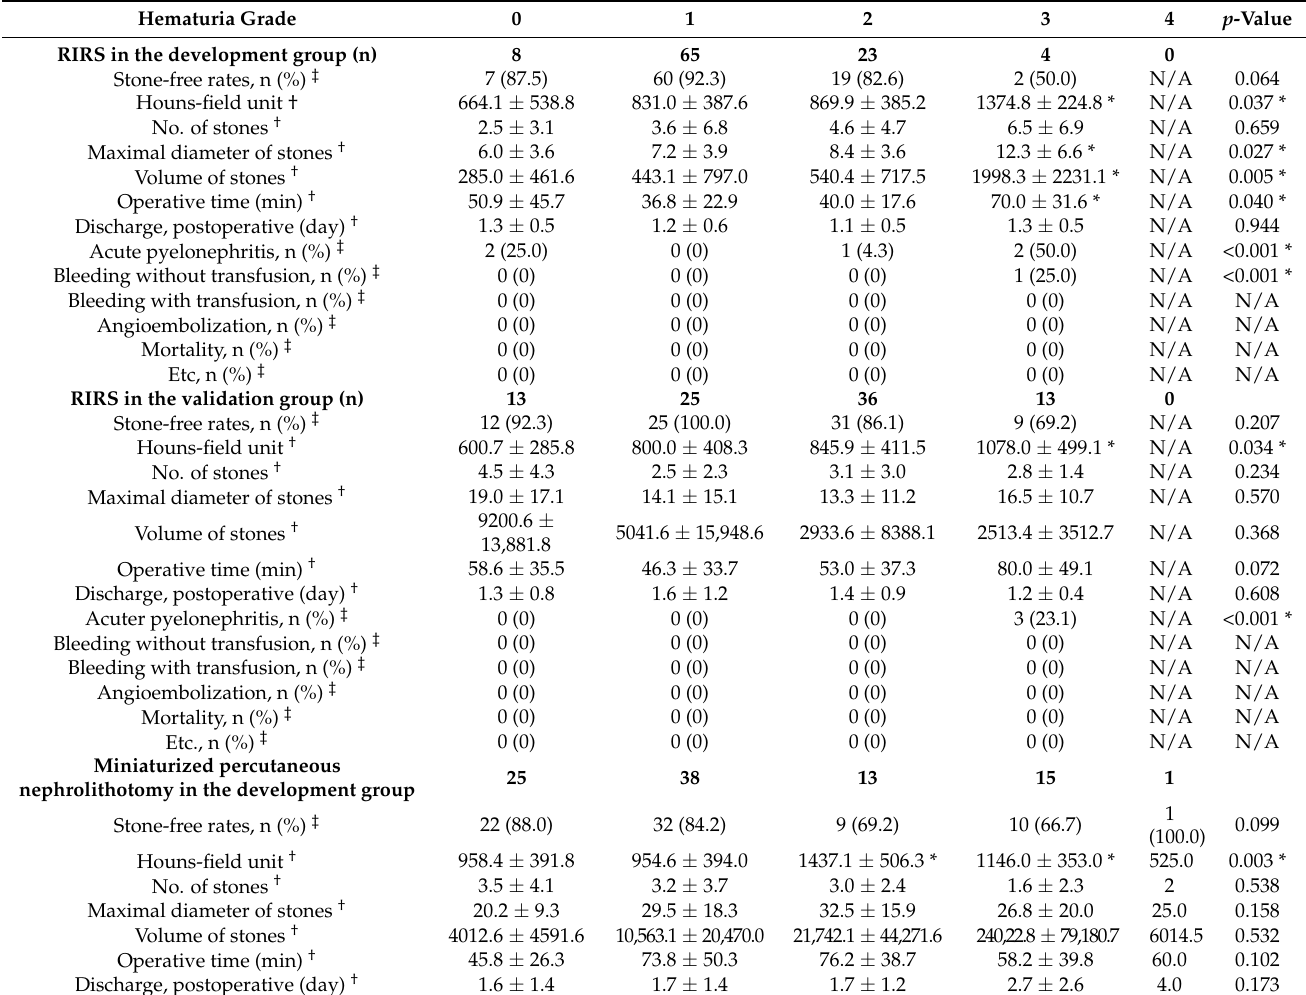
Table 3. Surgical outcomes of the development and validation